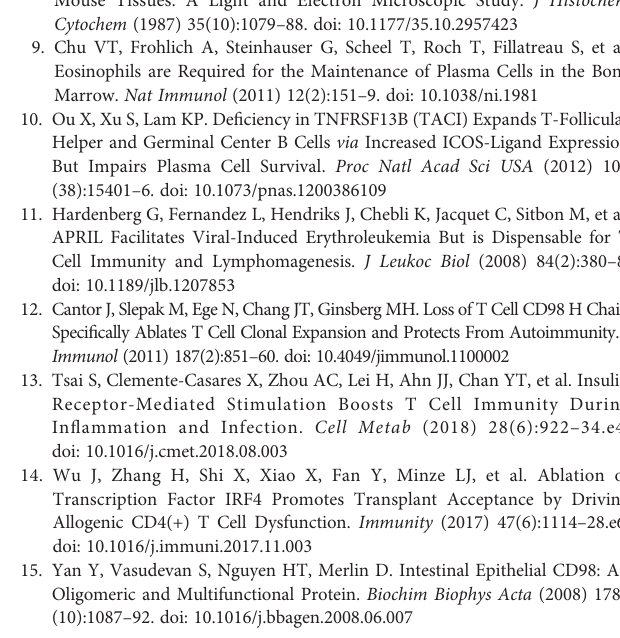
Supplementary Figure 5 | Microbial and T-dependent signals are involved in the regulation of the newly identi fi ed markers on ASCs. (A) Expression level (MFI) of the indicated markers by CD138 + BLIMP-1eGFP + ASCs from BM, spleen, and mLN from naive prdm1 eGFP mice. Groups were compared using two-way ANOVA with Geisser-Greenhouse correction followed by Tukey ’ s multiple comparisons test. (B, D) Representative FACS plots (left) and quanti fi cation (right) showing frequencies of ASCs co-expressing CD138 and CD39 from GF versus SPF (B) and Tcr bd -/- versus WT mice (D) . The populations were gated on live cells. (C, E) Histograms showing the expression level of indicated markers by CD138 + CD39 + ASCs from BM, spleen and mLN of GF compared with SPF mice (C) , and from BM and mLN of Tcr bd -/- compared with WT mice (E) . (F) Gating strategy (top) identifying CD19 + CD138 - B cells (P5), non-NP-reactive (P6) and NP-reactive CD138 + ASCs (P7). The graph (bottom) shows the frequency of NP-reactive versus non-NP-reactive within CD138 + ASCs. (G) Heat map of the expression level of the indicated markers by CD19 + CD138 - B cells, NP-reactive and non-NP-reactive CD138 + ASCs that were identi fi ed as in Supplementary . Data were calculated as described in Figure 5A, 5C and 5F . (H, I) Representative FACS plots and graph showing the frequency of LAG-3 + within CD138 + CD39 + ASCs from 5 versus 24 months old WT mice (F) and Tcr bd -/- versus WT mice (G) . Groups were compared using unpaired t test with Welch ’ s correction for B, C, D, F and G. Data show compilation of at least two independent experiments (n=5-9 mice/group). Data show mean ± SEM ( ∗ p < 0.05, ∗∗ p < 0.01, ∗∗∗ p < 0.001, ∗∗∗∗ p < 0.0001). P values >0.05 are not shown. Supplementary Figure6 | High CD39 and CD326 surface expression identi fi es a BM speci fi c ASC subpopulation in SLE. (A) Representative FACS plots showingthe expression of CD138, CD39, CD81, and CD130 by ASCs from BM, spleen, and mLN from sick Sle123 mice. The populations were gated on live cells. (B) Heat map shows the expression level of indicated markers by CD138 + CD39 + ASCs from BM, spleen, and mLN of healthy and sick Sle123 mice. The data were obtained as described in Figure 5A, 5C and 5F . (C) Quanti fi cation of the expression of CD39 and CD326 by LAG-3 + and LAG-3 - ASCs in spleen (left) and mLN (right) of healthy and sick Sle123 . Groups were compared using two-way ANOVA followed by Dunnett ’ s multiple comparisons test. The MFI values are shown in the graph. (D) Representative FACS plots showing no subpopulation co-expressing high levels of CD39 and CD326 within LAG-3 - ASCs in spleen, mLN, and kidney of sick Sle123 . (E) Spearman correlation between the frequencies of CD39 ++ CD326 ++ within LAG- 3 - ASCs and anti-dsDNA antibody titer for IgG. Data show compilation of two independent experiments (n=6 mice/group). Data show mean ± SEM ( ∗∗ p < 0.01, ∗∗∗∗ p <